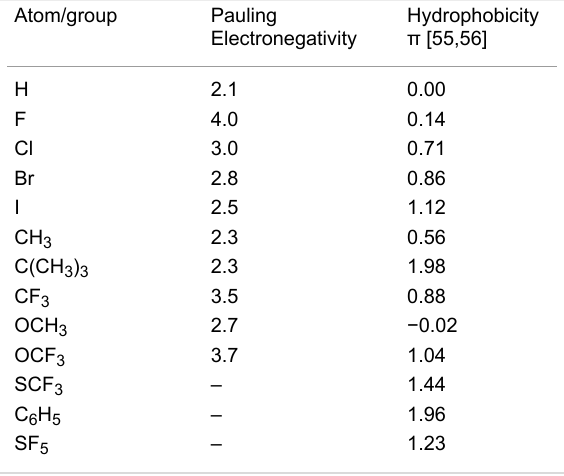
Table 7: Electronegativities and Hydrophobic Parameters for various